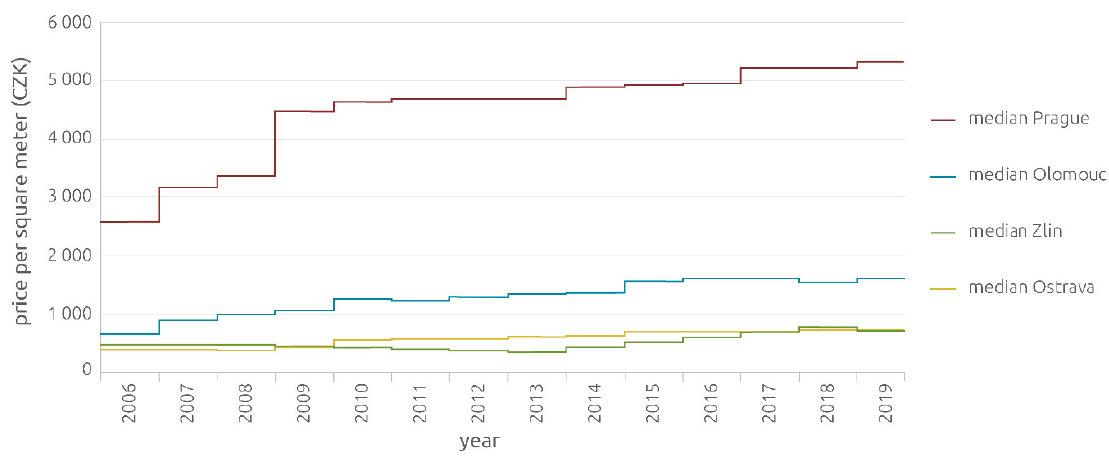
Figure 2. Land price median and mean value development. Table 2. Development in land parcels between 2006 and 2019.